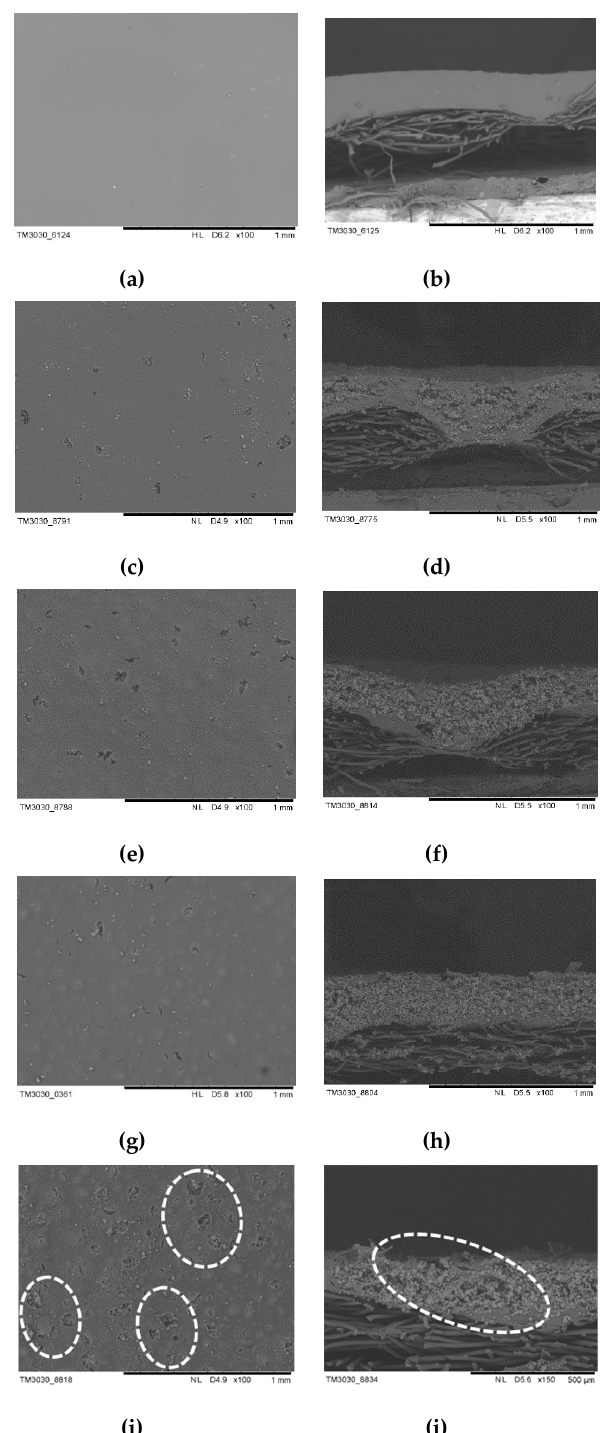
Figure 5. SEM images of the thermal insulation layer prepared at different SiO 2 aerogel slurry addition amounts: ( a , b ) 0 wt %; ( c , d ) 30 wt %; ( e , f ) 50 wt %; ( g , h ) 70 wt %; ( i , j ) 80 wt %. the circles in ( i , j ) represent holes and cracks.